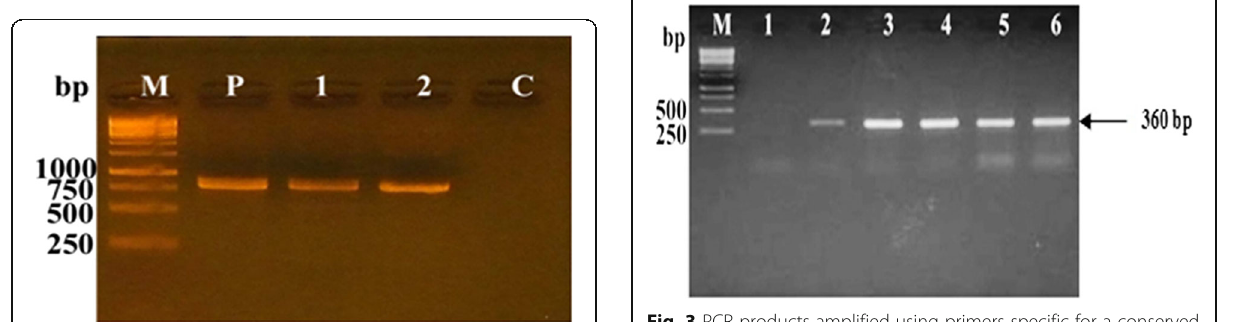
Fig. 3 PCR products amplified using primers specific for a conserved region of the fungal β -tubulin gene. M: 1 Kbp DNA ladder, 1: untreated rice, 2: Beauveria bassiana , 3-6: rice samples treated